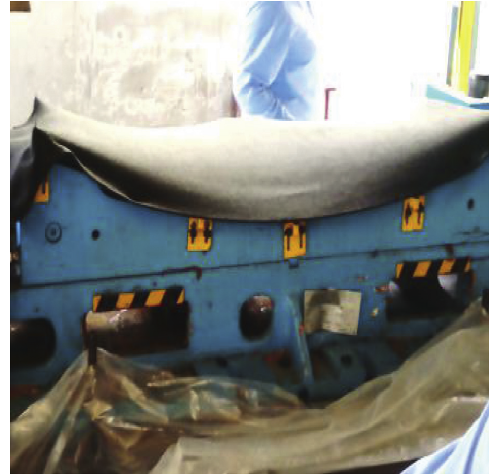
Figure 11: Fixing sheet.